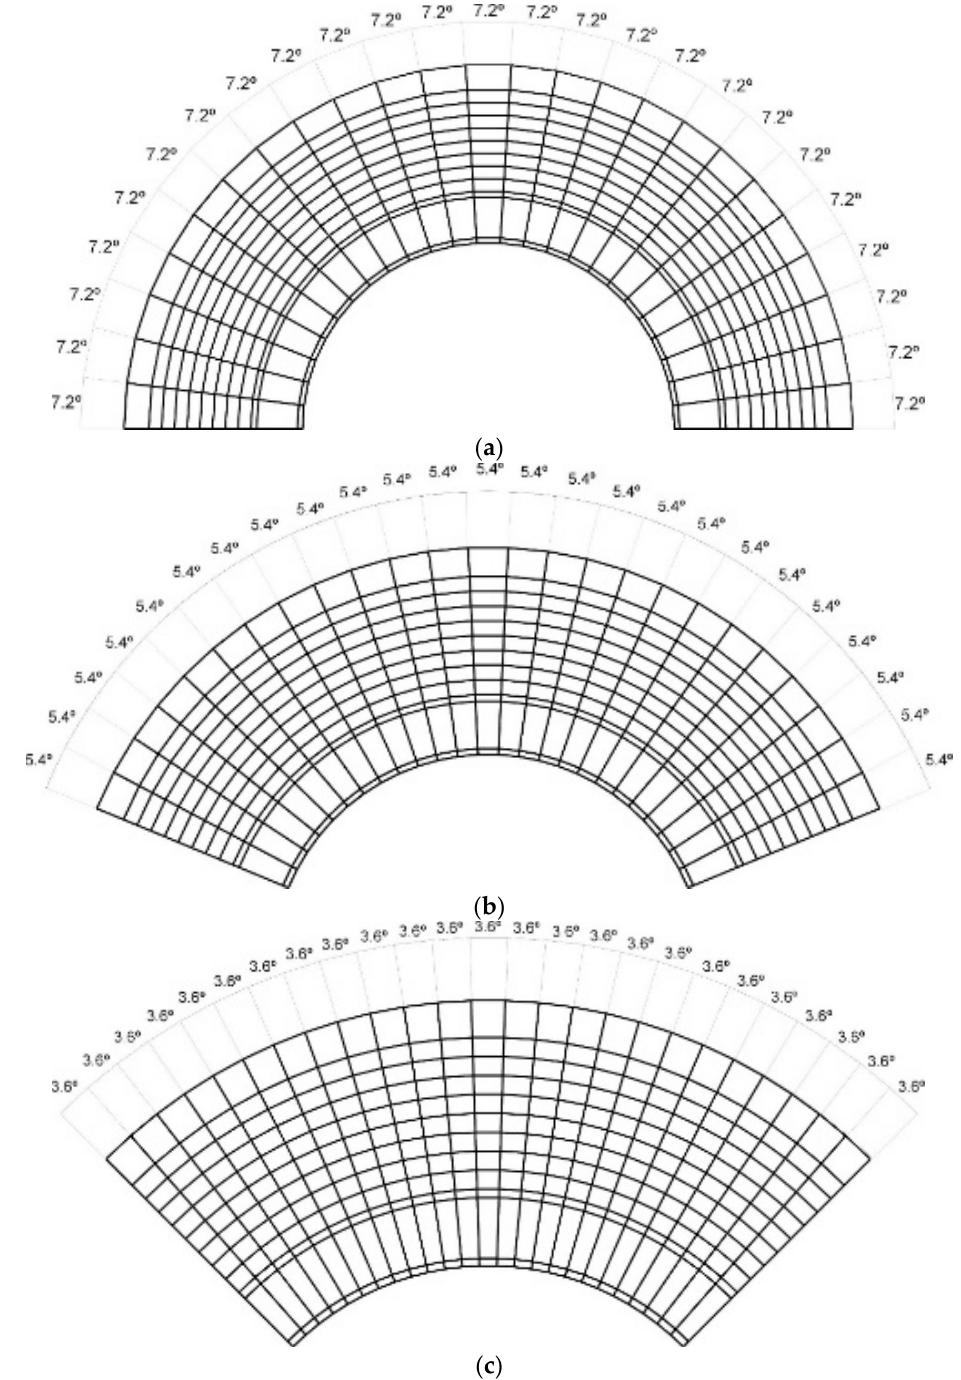
Figure 4. Scheme of the auditorium and the details of the opening angle of the DSF system. ( a ) Case D, ( b ) Case E, and ( c ) Case F. Three-dimensional top view.